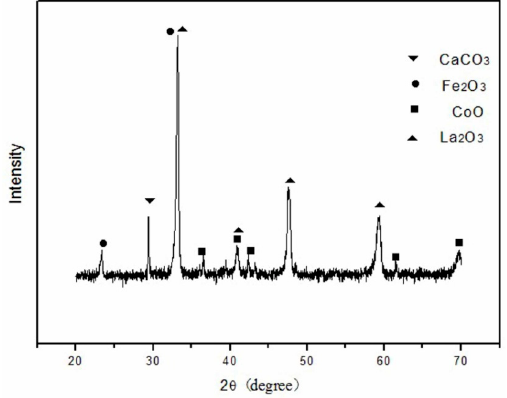
Figure 3. XRD patterns of La 0.5 Ca 0.5 Co 0.8 Fe 0.2 O 2.698 after complete carbonation at 850 ℃ .